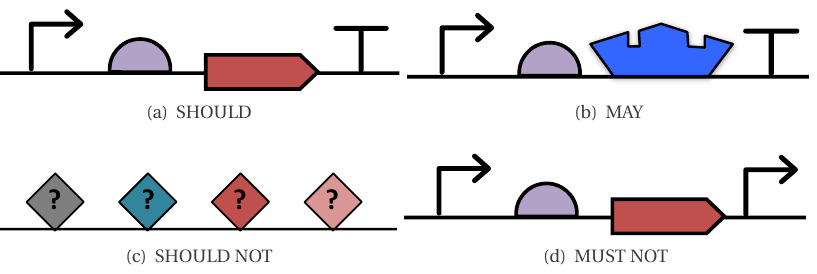
Figure 14: Examples of recommended, allowed, and forbidden representation of a ComponentDefinition comprising a sequence of promoter, ribosome entry site, CDS, and terminator: (a) is RECOMMENDED because it uses the preferred variant of the most specific defined glyphs, (b) is allowed because it uses some novel custom non-conflicting symbol, not matching any glyph defined in this document, to encode more specific information about the particular CDS, (c) is recommended against because it uses less specific glyphs, and (d) is forbidden because it use a promoter symbol to represent the